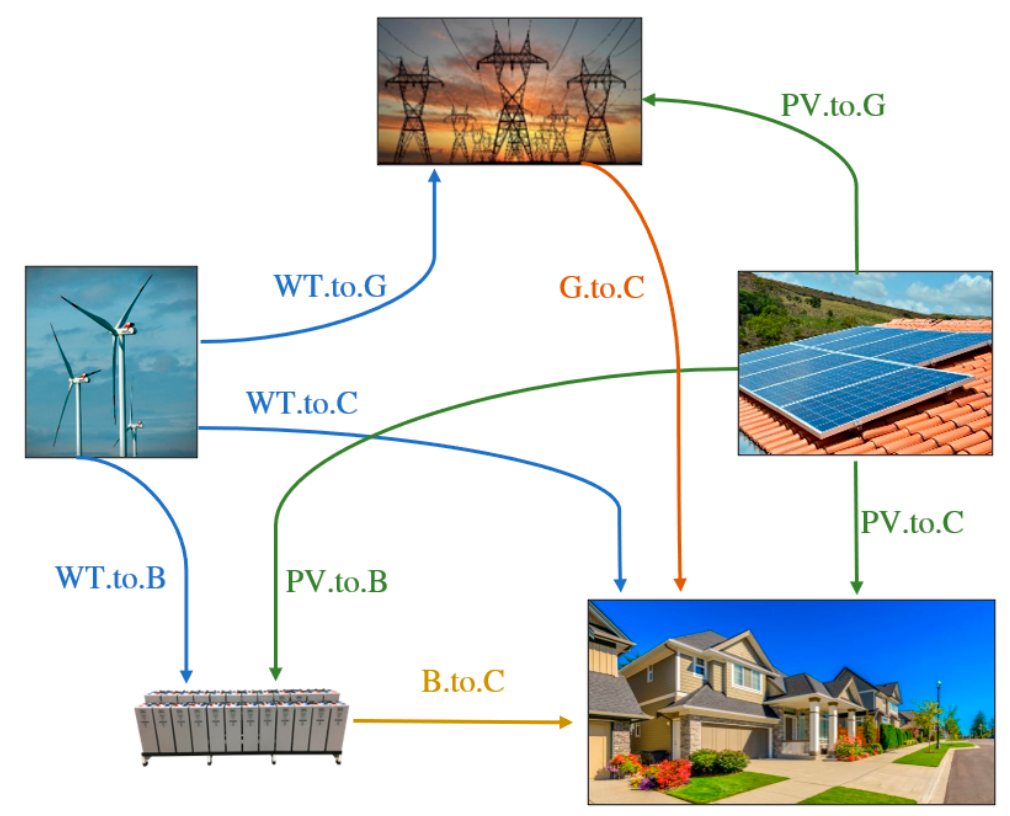
Figure 3. Physical model and energy flows within the microgrid. Source: self-elaboration. Images under a CC BY-SA license.